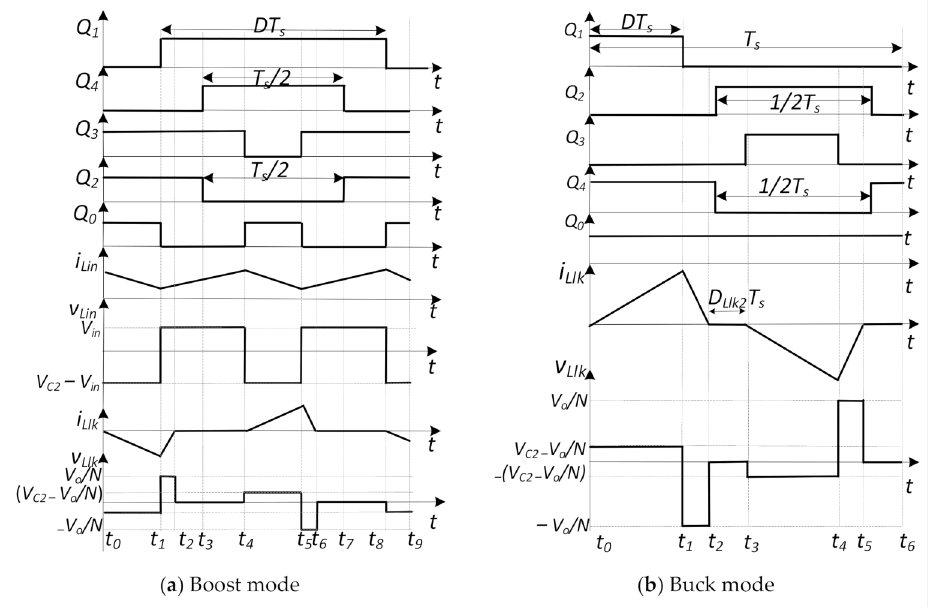
Figure 4. Switching sequence diagram in boost and buck